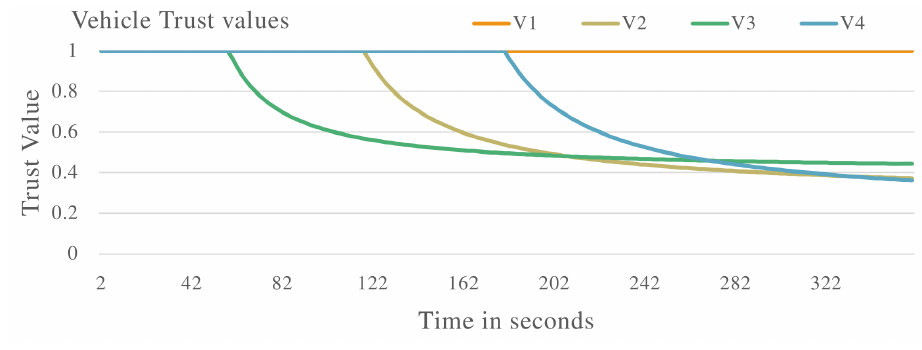
Figure 6. Vehicle trust values with malicious vehicles that are delaying packets in the